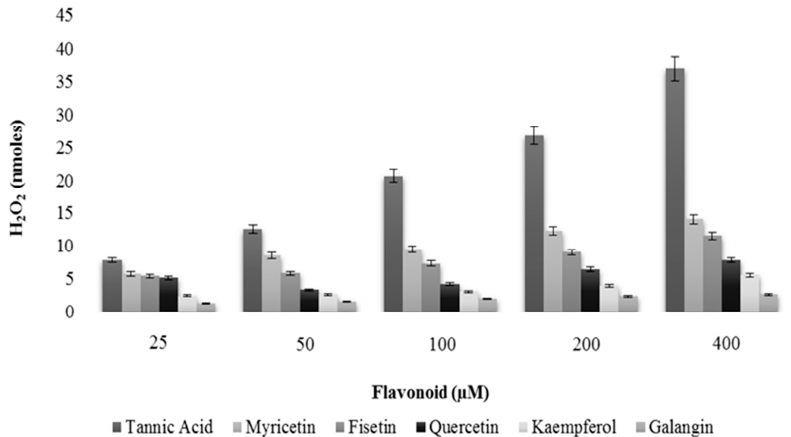
Figure 4. A comparison of the rate of H 2 O 2 formation by tannic acid, myricetin, fisetin, quercetin, kaempferol and galangin in the incubation medium as determined by FOX assay.